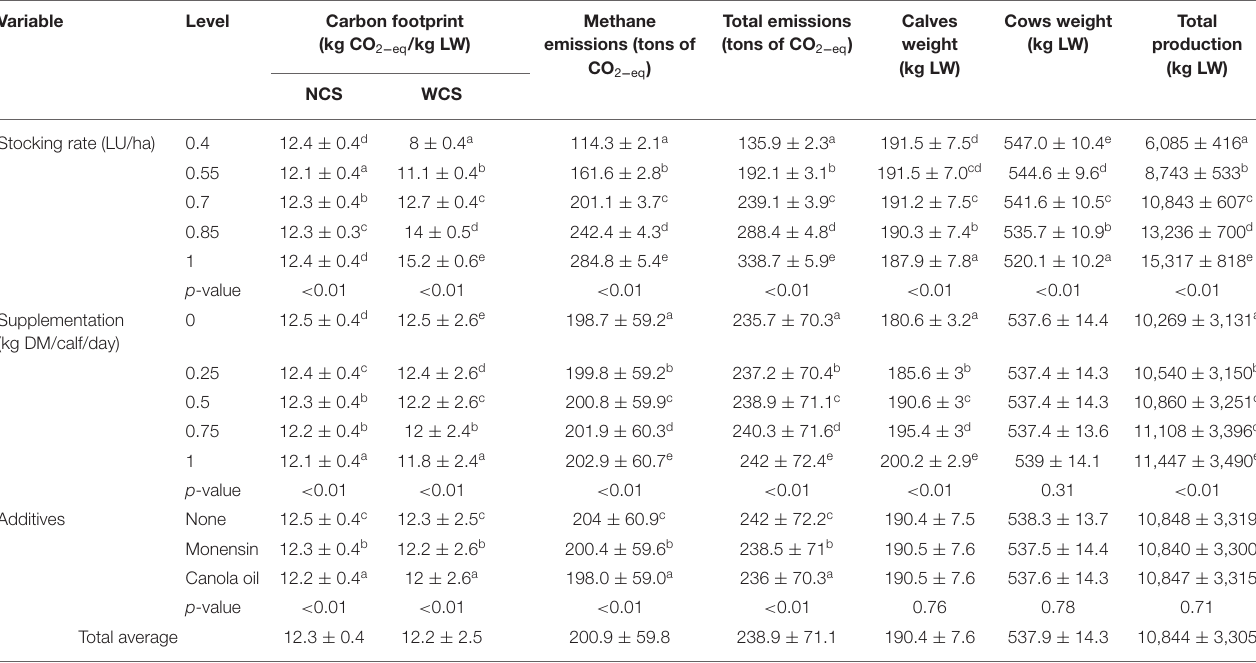
TABLE 4 | Simulated CF, total emissions, and productive variables in relation to stocking rate (0.4, 0.55, 0.7, 0.85, and 1 LU/ha), calf supplementation (creep feeding), and additives (monensin and canola oil).